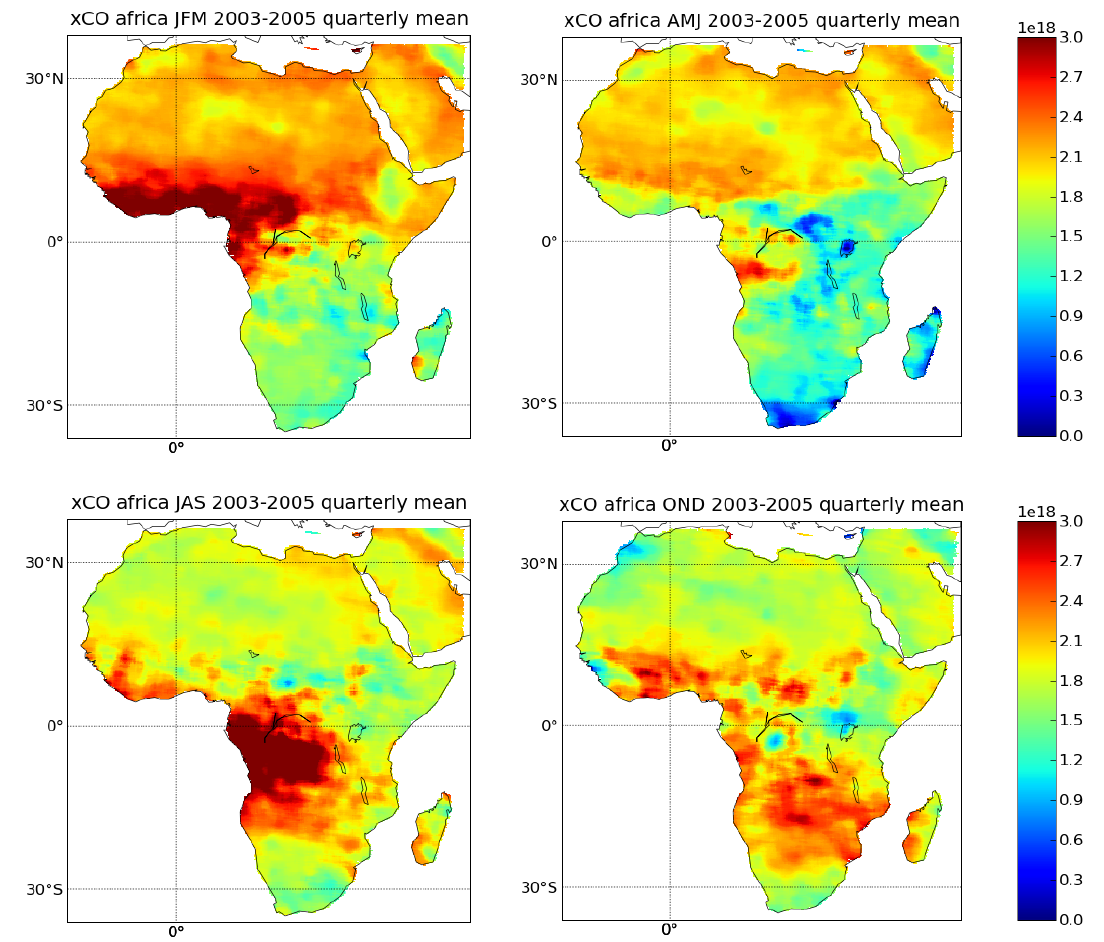
Fig. 18. Three year averages (2003 – 2005) of quarterly mean CO VCDs [ molec / cm 2 ] over Africa. From top-left to bottom-right: January-February-March, April-May-June, July-August-September, and October-November-December.